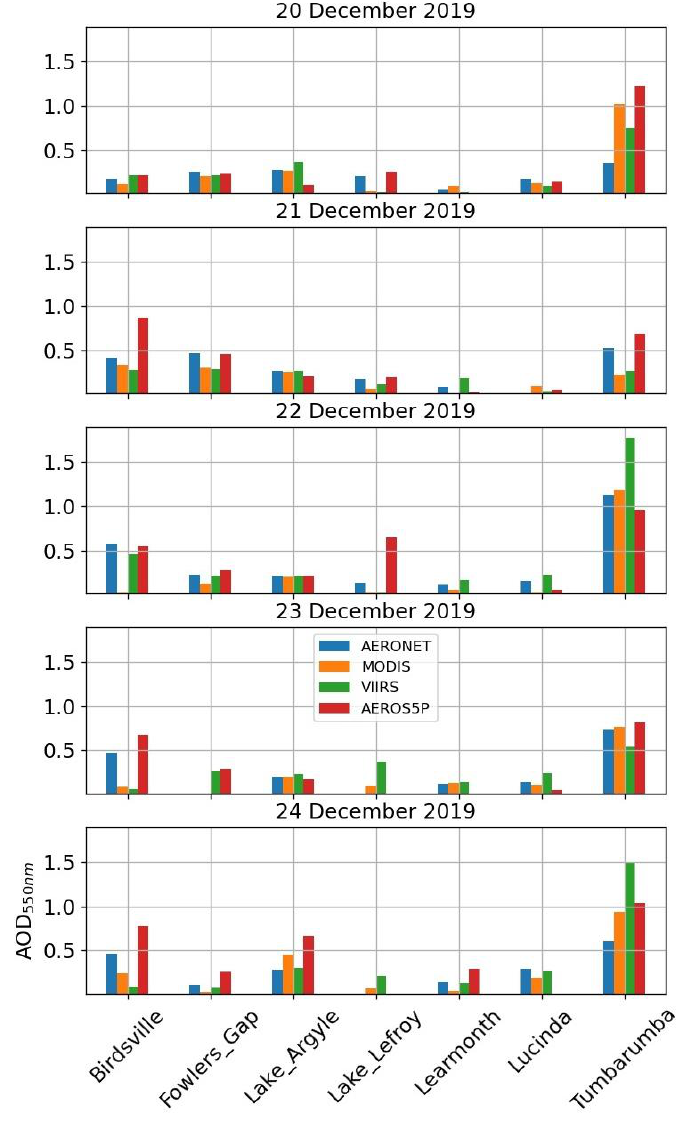
Figure 3. Comparison of AOD at 550 nm measured at 7 AERONET stations in Australia by sun photometer with respect to three satellite products: AEROS5P, MODIS/Aqua and VIIRS on 20 to 24 December 2019 (one panel per day from the upper to lower one).